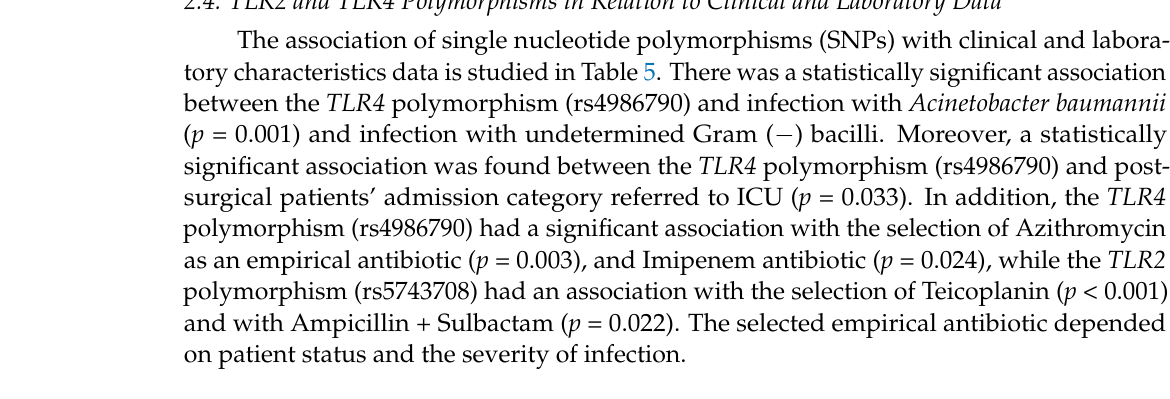
Table 5. Analysis for the association of variants with clinical and laboratory